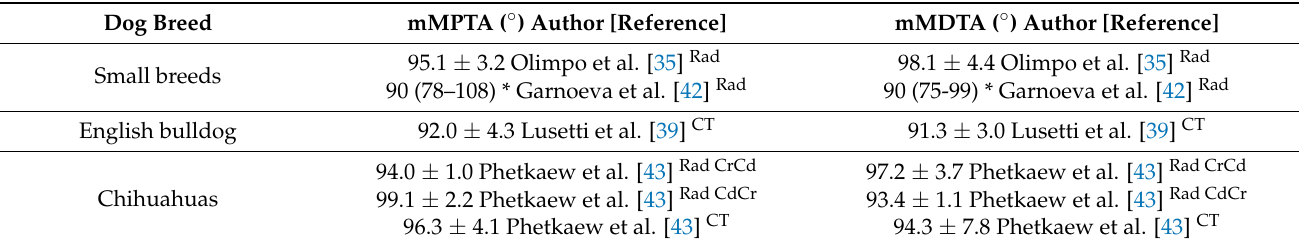
Table 14. Mean ± standard deviation of the mechanical medial proximal tibial angle and mechanical medial distal tibial angle in healthy